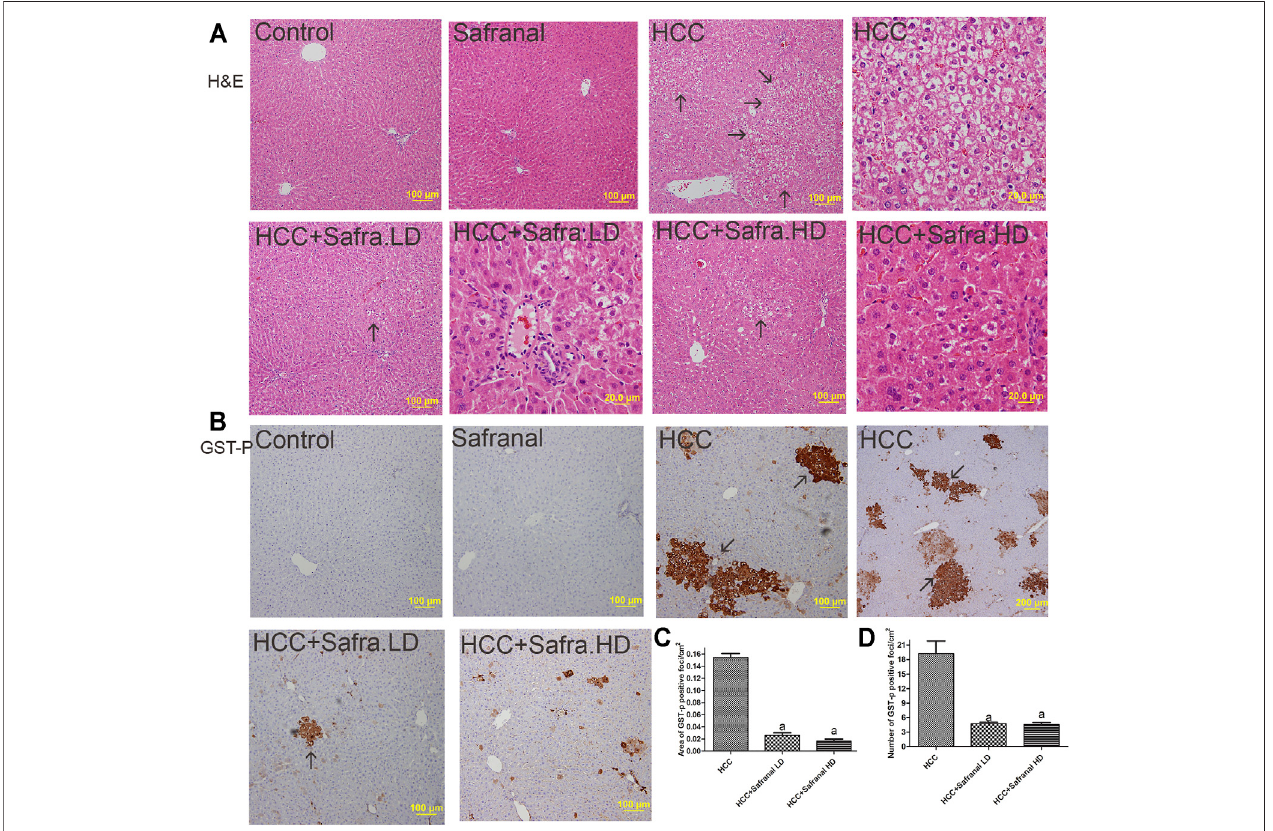
FIGURE 2 | Safranal inhibits DEN/2-AAF – induced induction of AHF (A) and of GST-p expression (B – D) . (A) Figures representing the livers of all groups with a magni fi cation of ×100 and ×400 (scale bars = 100 and 20 μ m) using H&E staining. AHF is indicated by arrows at ×100 magni fi cation (scale bar = 100 μ m). (B) Representative Images of immunohistochemical stains with GST-p of in all groups studied. The brown color represented those cells and is indicated by arrows. (C, D) Presentquantitativeanalysesin10 fi eldsofeachsectionoftheGST-p – positivefociandquantitativeregionanalysisoftheGST-p – positivefoci×100magni fi cations. Treatment of HCC rats with safranal decreased the number and area (mm 2 ) of GST-positive foci. The value was evaluated by one-way ANOVA followed by Dunnett ’ s t -test: a p < 0.05 vs. HCC group. Data are represented as mean ± SEM of six animals per group.